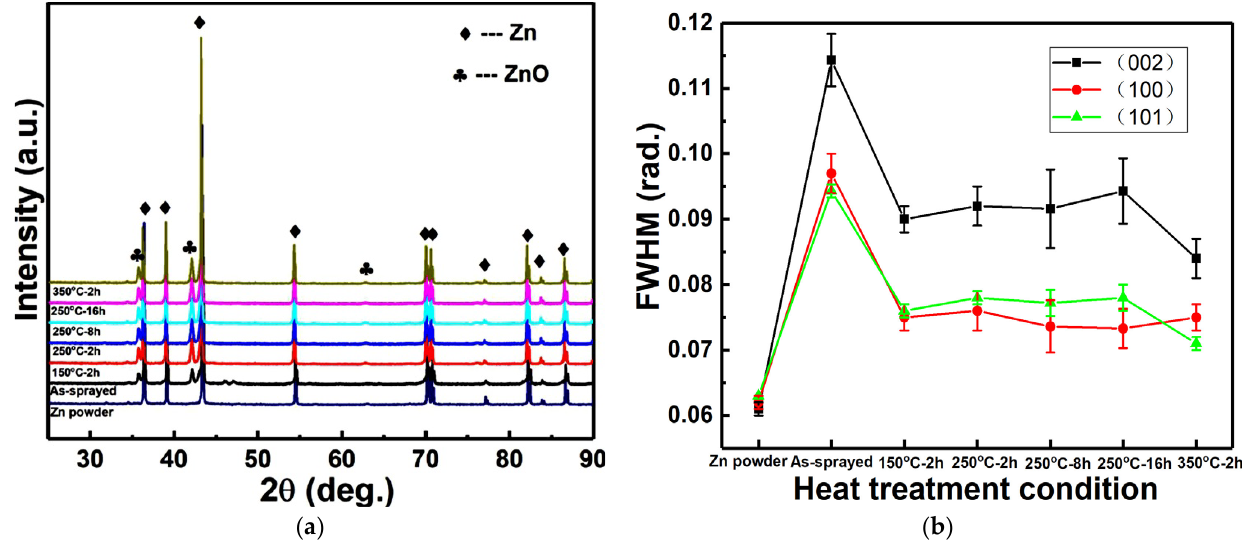
Figure 1. XRD patterns and FWHM of Zn coatings after different heating conditions. ( a ) XRD patterns; ( b ) FWHM of Zn phase.